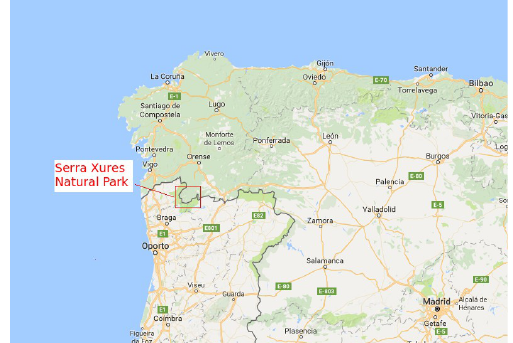
Figure 1. Situation of Serra Xures natural park.